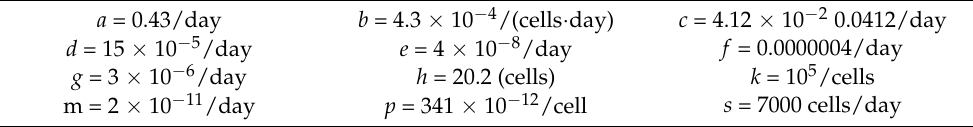
Table 2. Model parameter